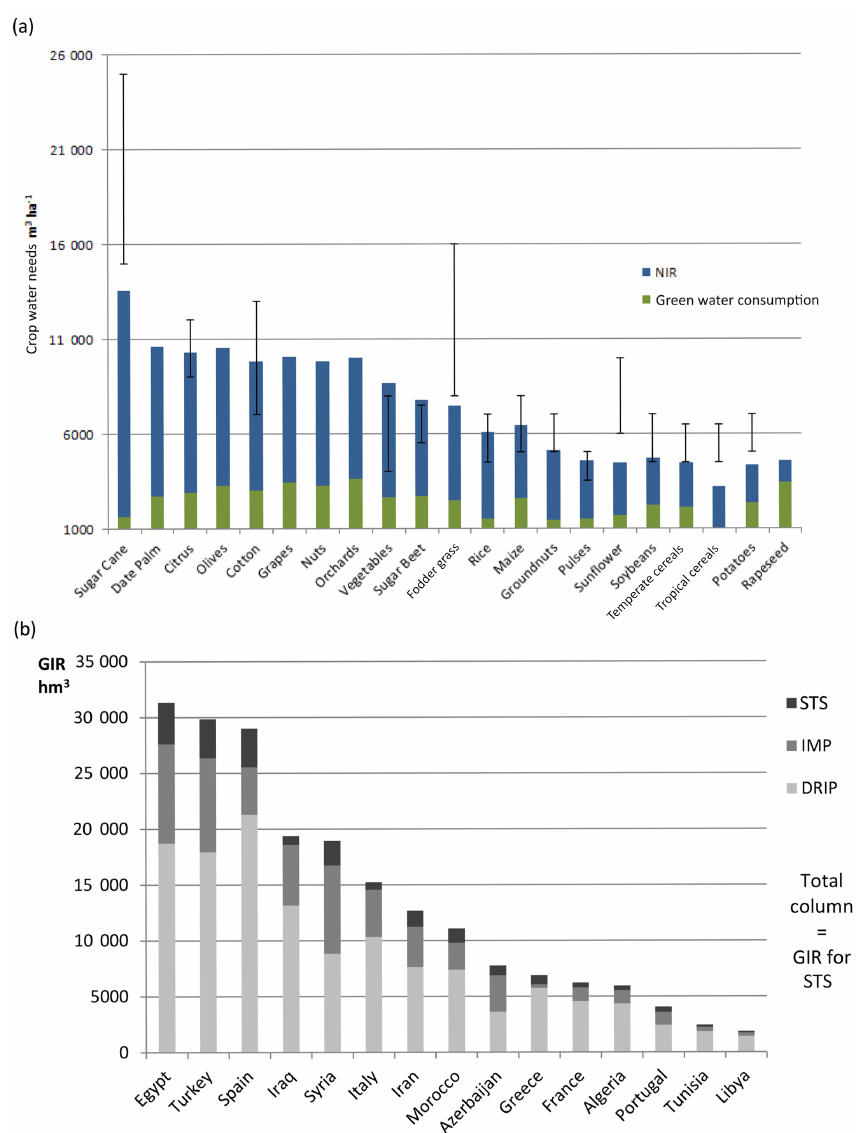
Figure 2. Panel (a) : net irrigation requirements and green water consumption aggregated for different crops in the Mediterranean region, as average of 2000–2009. Total bar height represents the crop water needs. Error bars show the maximum and minimum values for crop water needs published by FAO (1986). Note that the y axis starts at 1000m 3 ha − 1 . Panel (b) : national gross irrigation water requirements (GIR) for current irrigation systems (STS), improved irrigation systems (IMP) and optimized irrigation systems (DRIP) as the average of the period